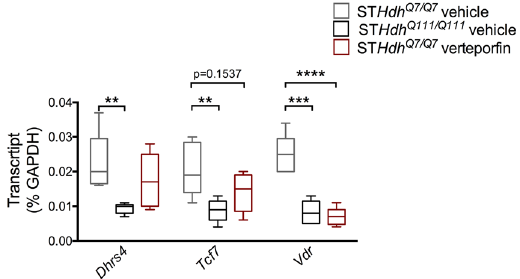
Figure 7. Disruption of YAP/TEAD interaction alters transcription. Two-way ANOVA demonstrated that there was a significant effect of gene [F(2, 12) = 23.87, p < 0.0001] but no effect of treatment [F(2, 36) = 1.144, p = 0.3298] or interaction [F(4, 36) = 2.019, p = 0.1124] on expression data from qPCR analysis. Tukey’s multiple comparison’s test a significant decrease in expression of the NADPH dehydrogenase ( Dhrs4 ) (p = 0.0025), transcription factor 7 ( Tcf7 ) (p = 0.0053), and vitamin D receptor ( Vdr ) (p = 0.0001) genes in untreated ST Hdh Q7/Q7 cells (light grey) compared to untreated ST Hdh Q111/Q111 cells (black; n = 5). In addition, verteporfin treatment (10 mM, 24 hours) in ST Hdh Q7/Q7 cells (red; n = 5) also significantly decreased Vdr expression (p < 0.0001, Tukey’s post-hoc test) and produced a trend towards a decrease in Tcf7 expression (p = 0.1537, Tukey’s post-hoc test) compared to untreated ST Hdh Q7/Q7 cells. However, verteporfin treatment did not affect Dhrs4 (p = 0.3535, Tukey’s post-hoc test) expression in ST Hdh Q7/Q7 cells. Data are presented as median and min-max values. ** p < 0.01, ** p < 0.001, **** p <